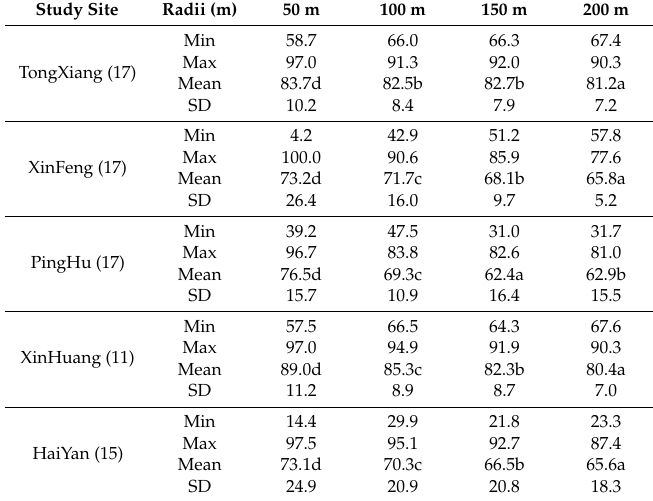
Table 2. Mean percentage of agricultural land to the total landscape area in the five study sites *. Study